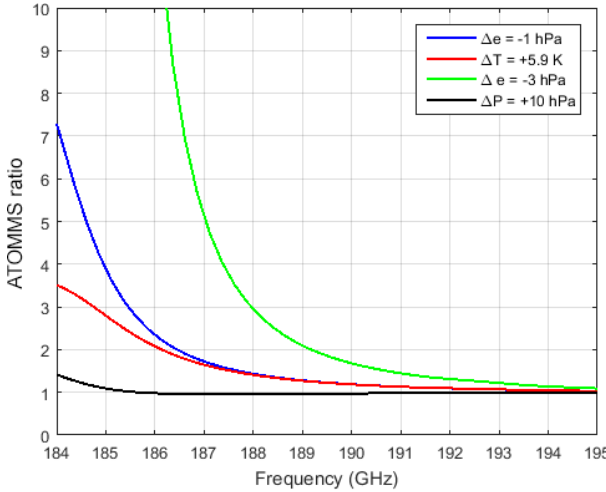
Figure 6. ATOMMS ratio for four changes in the atmospheric con- ditions along the 5.4km observation path relative to reference con- ditions: vapor pressure decreased by 1hPa (blue), temperature in- creased by 5.9K (red), vapor pressure decreased by 3hPa (green) and air pressure increased by 10hPa (black). The reference condi- tions were air pressure = 743hPa, air temperature = 20 ◦ C and va- por pressure =